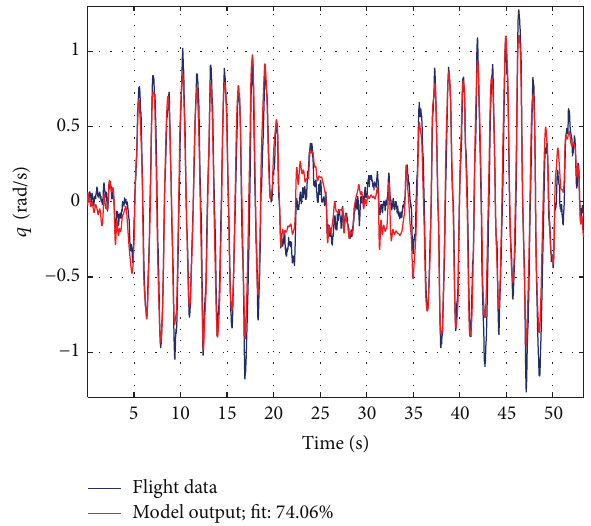
Figure 4: The pitch rate response of the flight data and the model